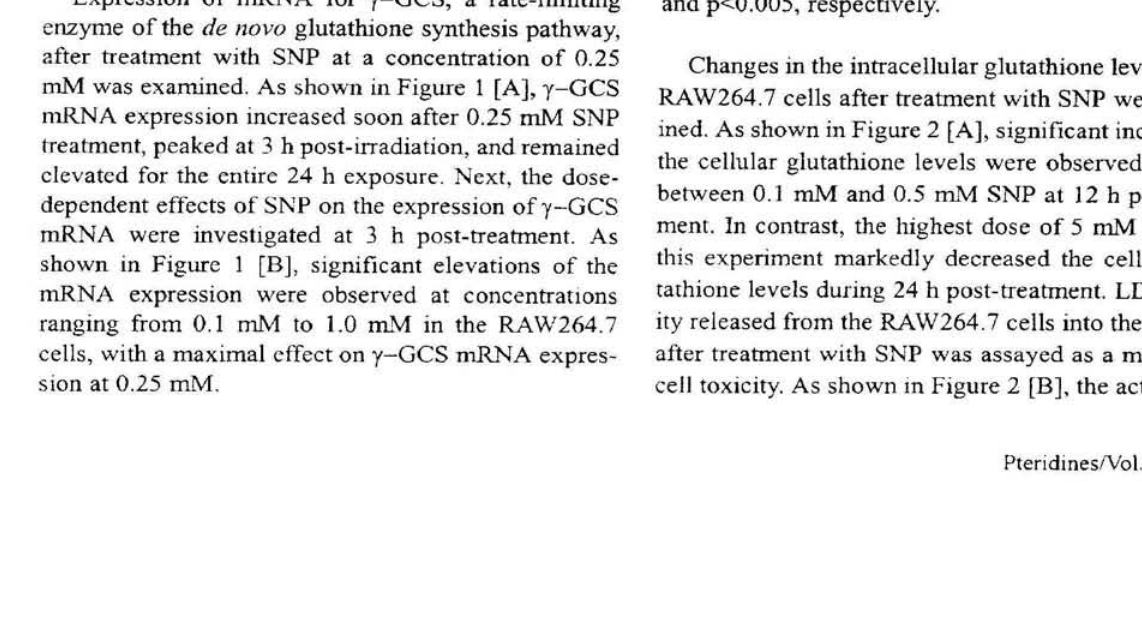
Figure 1. Dose- and time-dependent effects of sodium nitroprusside (SNP) on γ-glutamylcysteine synthetase iy-GCS) mRNA level in RAW 264.7 cells. [A] Dose- response of SNP on γ-GCS mRNA expression. [B] Time course of the effect of SNP on γ-GCS mRNA at a concentration of 0.25 mM. Results of quantification of mRNA levels by densitometric analysis of the autoradiogram in RAW 264.7 cells treated with SNP Relative mRNA levels are indicated as the ratio of the γ-GCS mRNA level to the mRNA level of the house- keeping gene GAPDH. Each point indicates the mean ± SD of 3 independent assays. * and *** significantly different from the non-treated control group at p<0.05 and p<0.005,